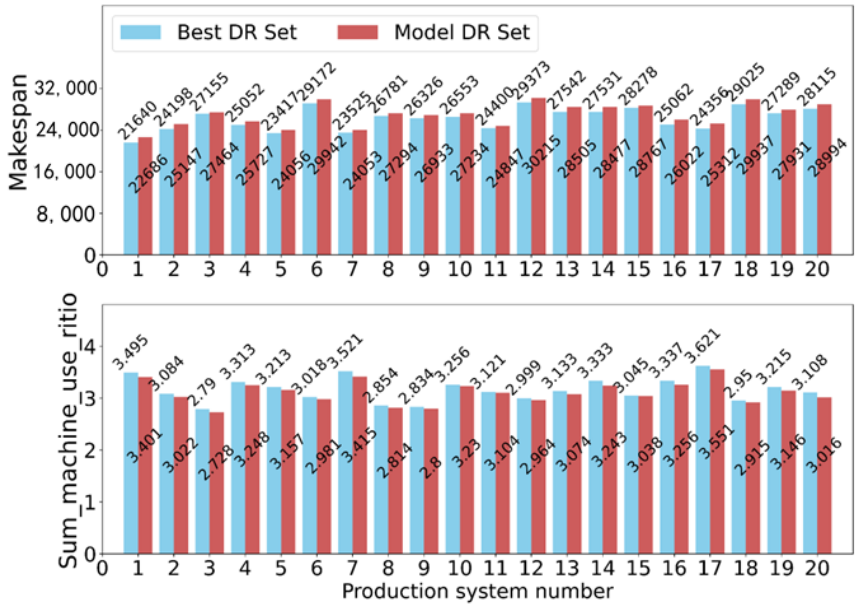
Figure 18. High job heterogeneity and a low manufacturing system load rate.